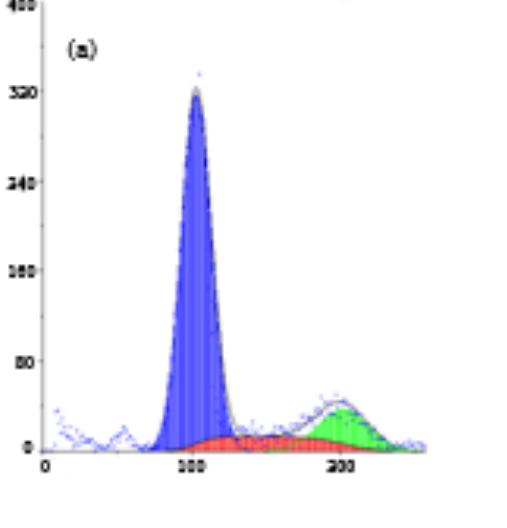
Figure 4. Flow cytometry analyses of nuclear DNA content. SMMC-7721 cells were treated with 0 nM B2 ( a ); 0.015 nM B2 ( b ) and 0.03 nM B2 ( c ) for 48 h. The x